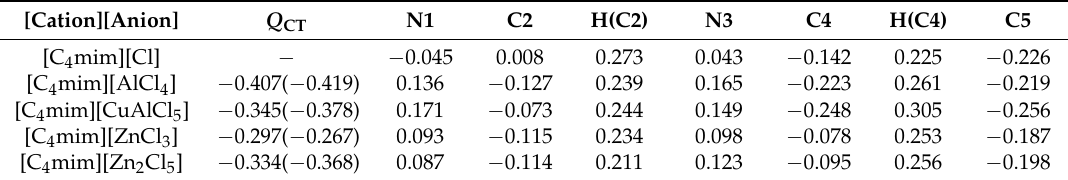
Table 3. The magnitude of the charge transfer from the unit (C 4 mim-Cl) to the metal chloride [ Q CT (IP → MCl x )], and the restrained electrostatic potentials (RESP) charges for the ILs under study 1.